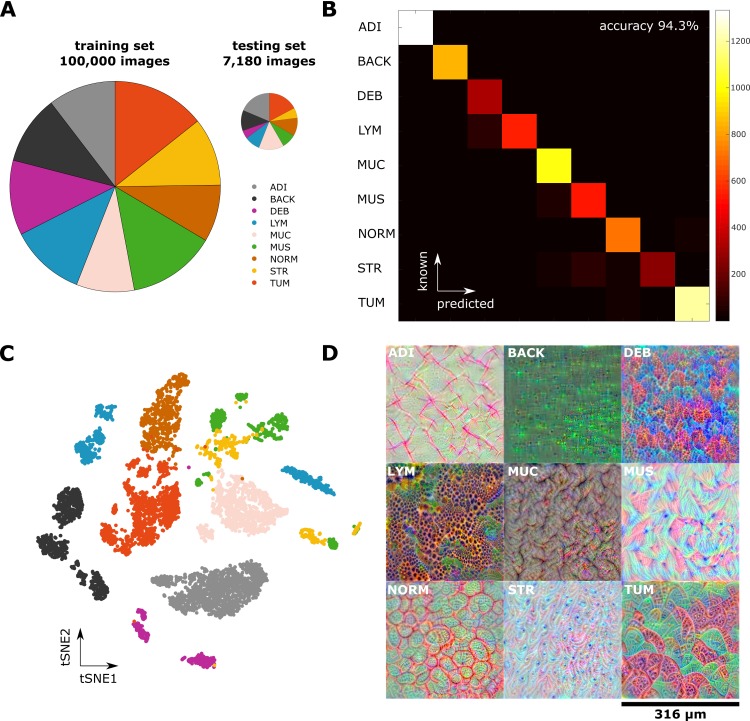
A CNN learns robust representations of histological images and attains high classification accuracy.(A) A nine-class training set containing 100,000 unique images and a testing set of 7,180 unique images. Classes are adipose, background, debris, lymphocytes, mucus, smooth muscle, normal mucosa, stroma, cancer epithelium. Pie area is proportional to sample number. (B) Confusion matrix of the CNN-based classification; overall accuracy is 94%. (C) tSNE of the testing set based on deep layer activations of the trained CNN. Tissue classes naturally aggregate in separate clusters, with close proximity of the TUM and NORM cluster and the MUS and STR cluster, respectively. (D) Deep dream visualization of the spatial patterns represented in the trained CNN. For all tissue classes, the network has learned to visually discern key features. For example, LYM are composed of tightly collected small round cells, and NORM is composed of glands in an even distribution pattern. ADI, adipose tissue; BACK, background; CNN, convolutional neural network; DEB, debris; LYM, lymphocytes; MUC, mucus; MUS, smooth muscle; NORM, normal mucosa; STR, stroma; tSNE, t-distributed stochastic neighbor embedding; TUM, cancer epithelium.